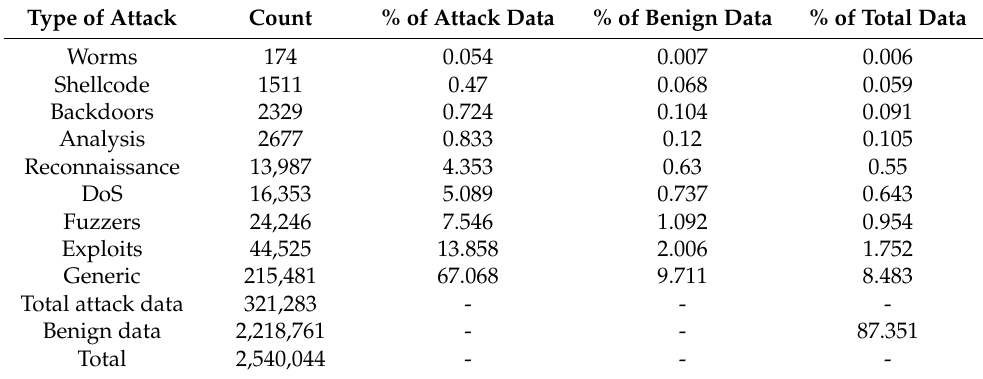
Table 1. UNSW-NB15: distribution of attack families [4].